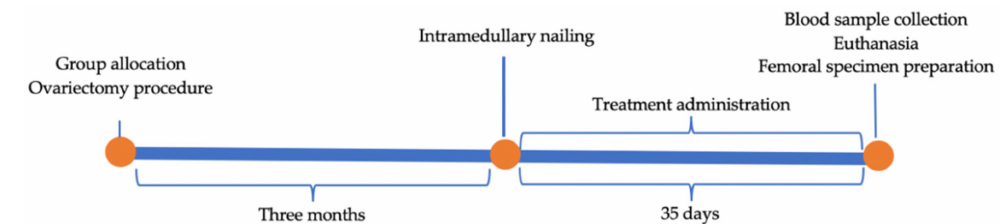
Figure 2. Project’s timeline: group allocation, ovariectomy procedures, intramedullary nailing, treatment administration, blood sample collection, euthanasia, and femoral specimen